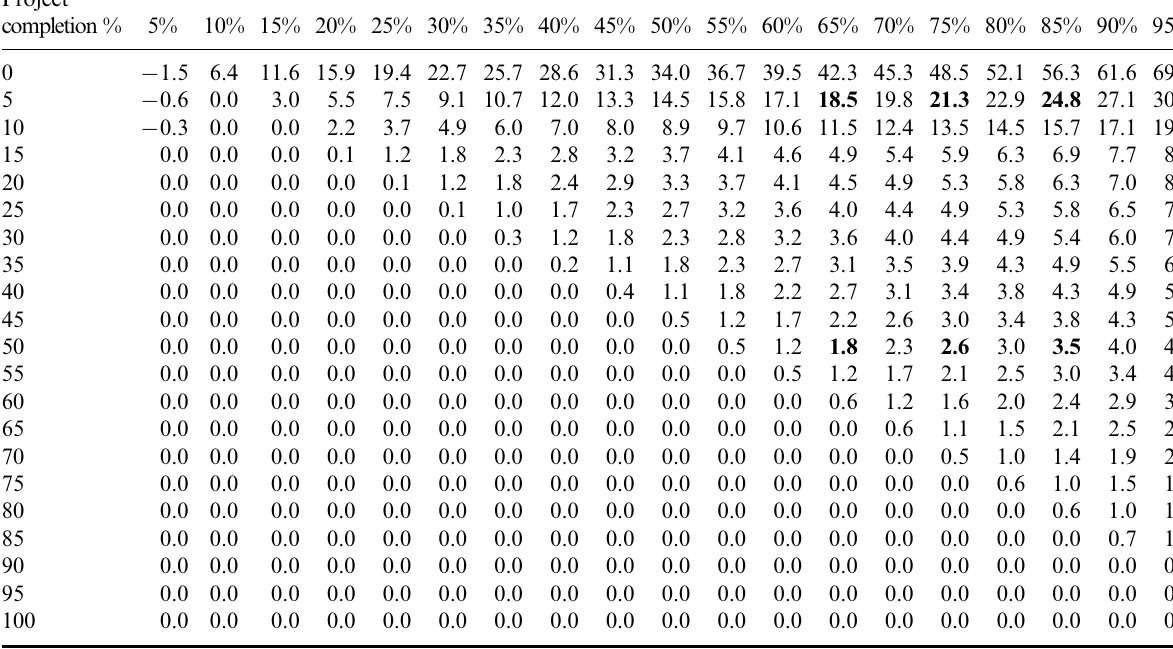
Table 5. Simulated unused contingency values as a percent of base duration using normal distribution Project completion